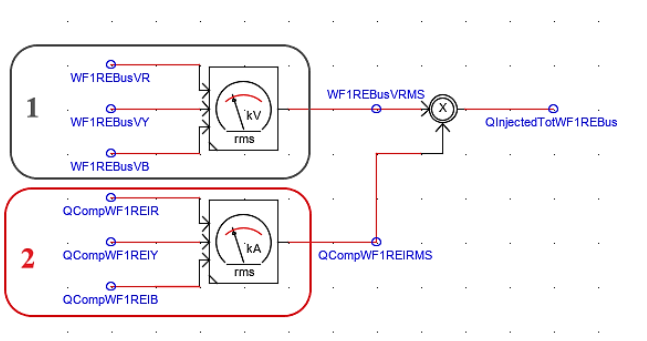
Figure 25. Monitoring and calculation logic for reactive power injection device using the RMS voltage and current.